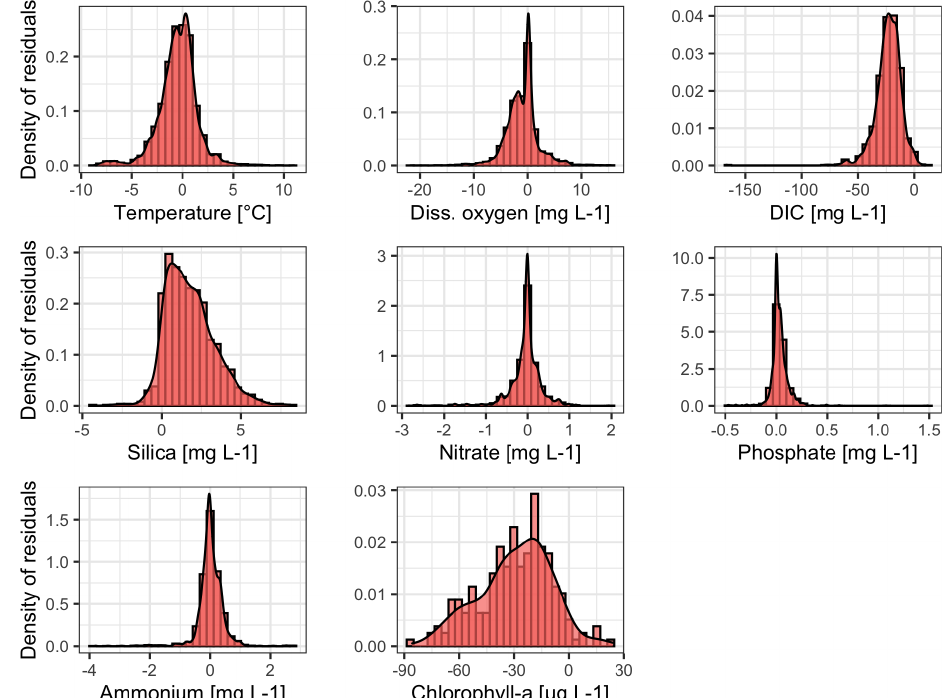
Figure 5. Density distributions of residuals (observed–modeled) for water temperature, dissolved oxygen, dissolved inorganic carbon (DIC), silica, nitrate, phosphate, ammonium, and phytoplankton. The density distributions include residuals over all data points (over each time step over each depth), calculated from observations minus model